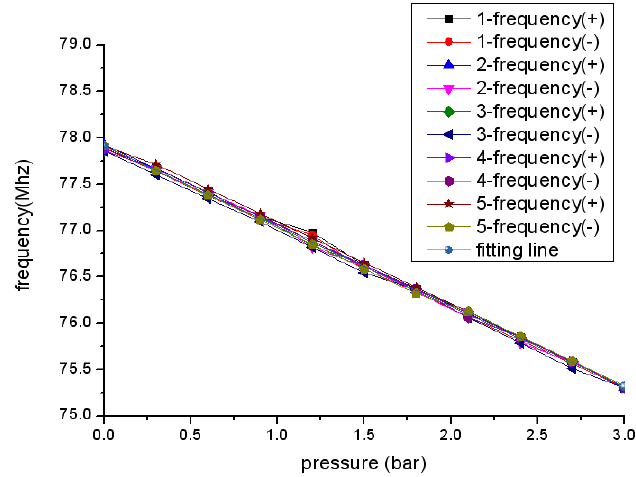
Figure 9. Measured resonant frequency versus pressure